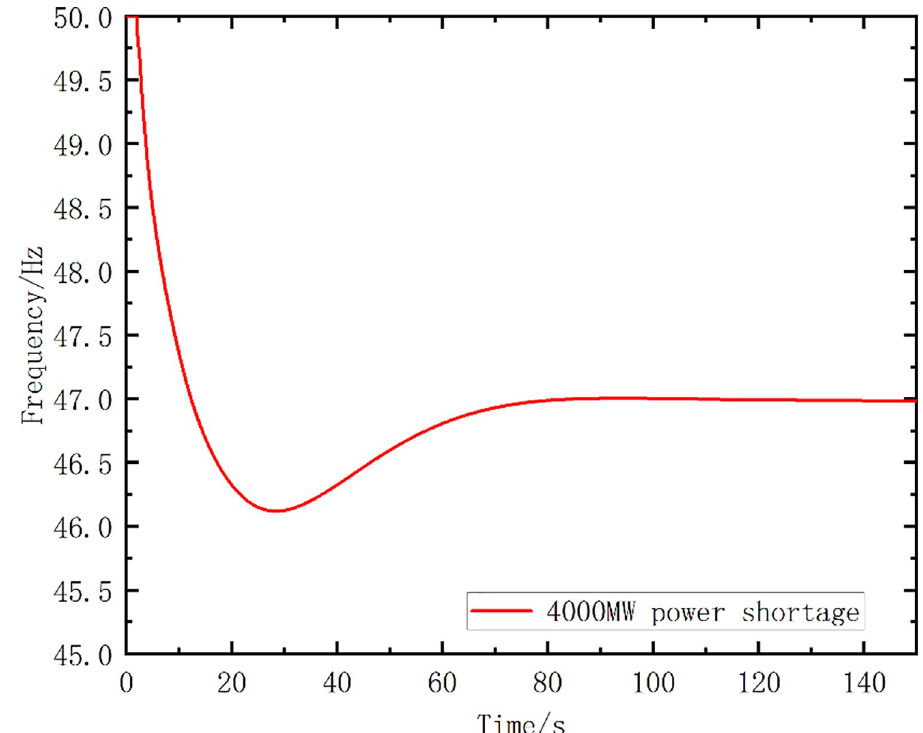
Fig 12. The frequency curve without any